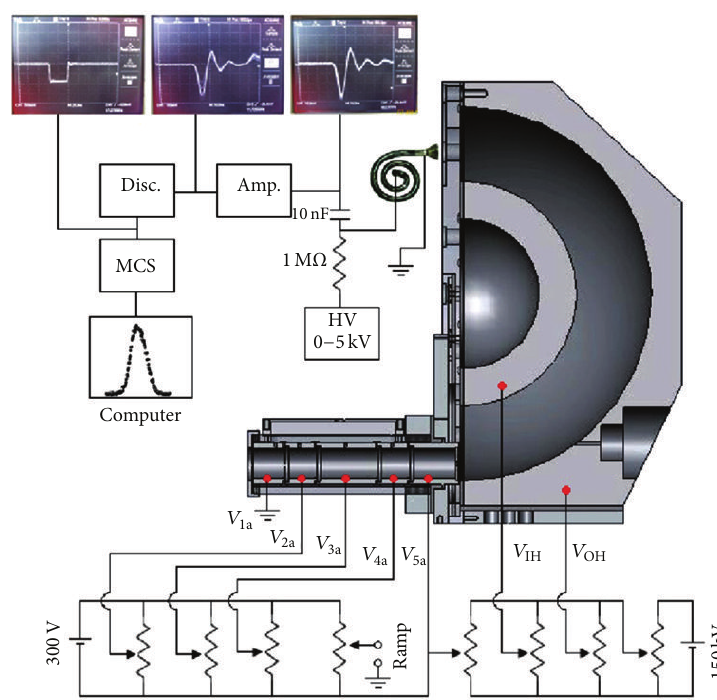
Figure 6: The schematic diagrams of the electron energy analyzer and detector with electric and signal